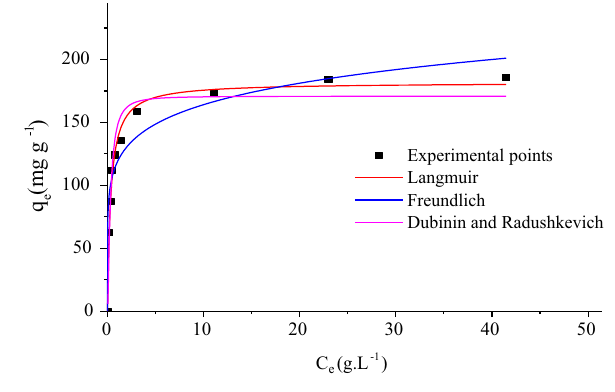
Fig. 9 Adsorption isotherm models fitted to experimental